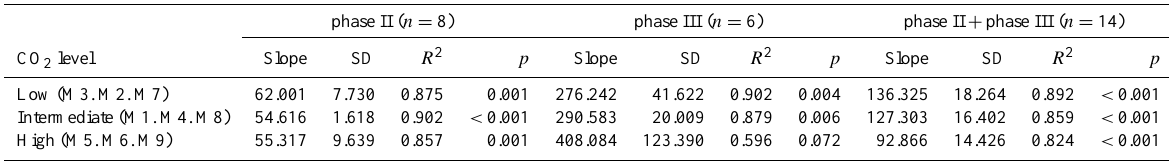
Table 4. C:P uptake ratios, standard deviations and the results of the F test on linear regressions analysis in phases II and III and the post-nutrient period (phase II + phase III) (see explanations in